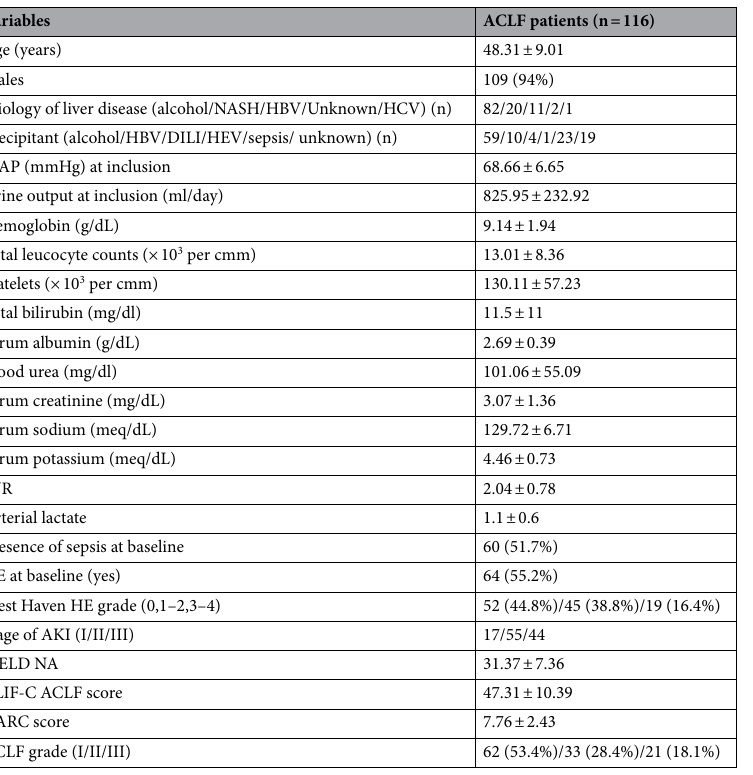
Table 1. Baseline characteristics of the included patients. EASL European association for the study of the liver, ACLF acute-on-chronic liver failure, HBV hepatitis B virus, DILI drug induced liver injury, HEV hepatitis E virus, HCV hepatitis C virus, MAP mean arterial pressure, INR international normalized ratio, HE hepatic encephalopathy, MELD NA model for end-stage liver disease sodium, CLIF-C ACLF chronic liver failure consortium acute-on-chronic liver failure score, AARC APASL ACLF research